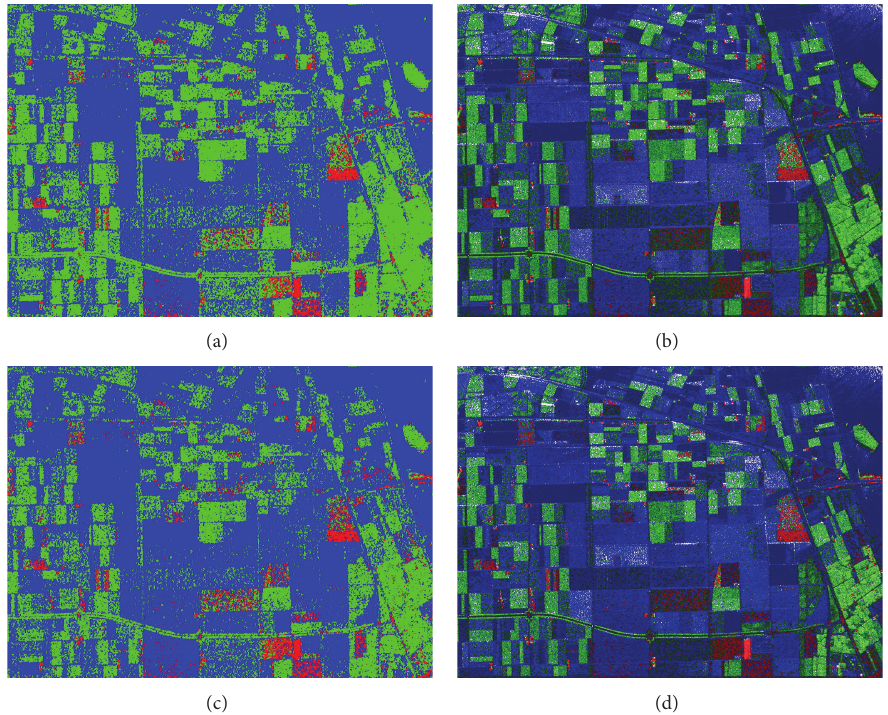
Figure 2: Initial classification results and those after being clustered. (a) Initial classification results using Freeman model. (b) The classification results after being clustered by 4 iterations. (c) Initial classification results using Yamaguchi model. (d) The classification results after being clustered by 4